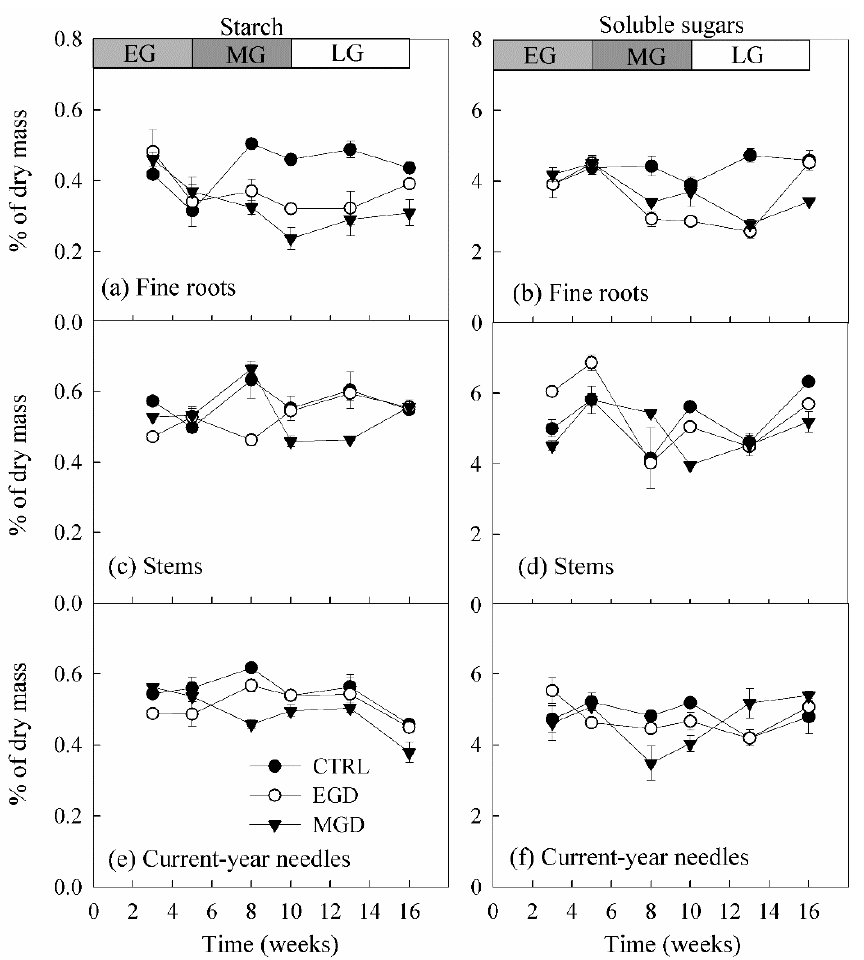
Figure 5. Starch content (left) and soluble sugar content (right) in fine roots ( a , d ), stems ( b , e ) and current-year needles ( c , f ) of Mongolian pine saplings by treatment. CTRL indicates the control. EGD and MGD indicate drought stress treatment in the early- (EG) and mid- (MG) growing seasons, respectively. EG, MG and LG refer to the early- (weeks 1–5), mid- (weeks 6–10) and late- (weeks 11–16) growing season, respectively. Time indicates weeks from the beginning of the experiment. Bars indicate standard error ( n = 4).